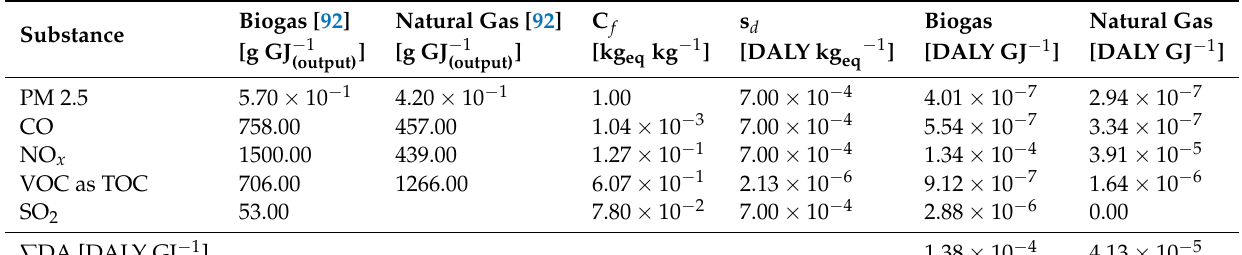
Table 19. Damage assessment of regulated emissions listed in Reference